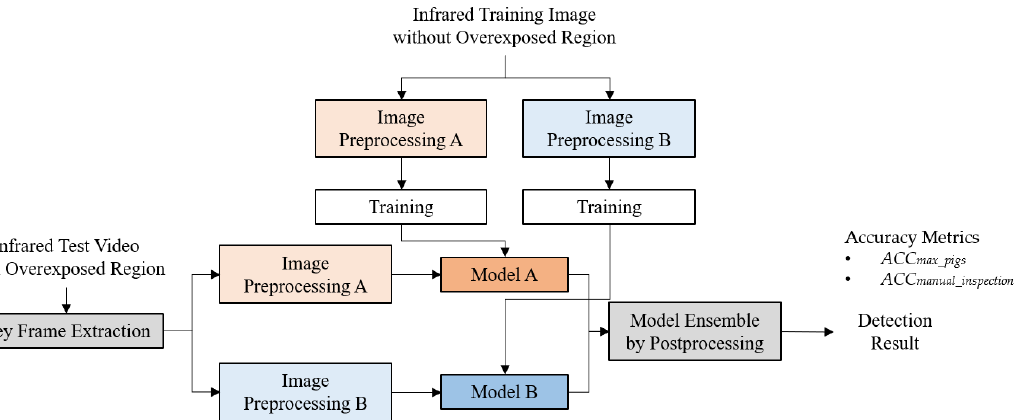
Figure 3. Overview of the proposed method